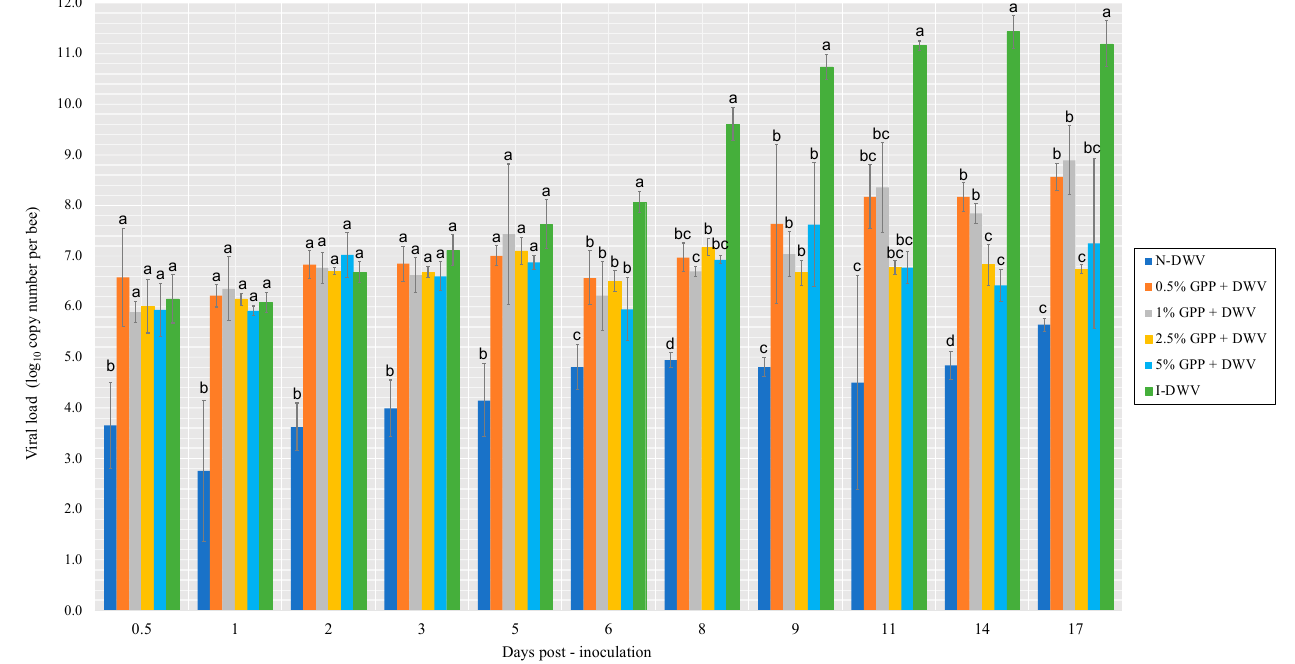
Figure 3. DWV loads in worker honeybees recorded in days post-inoculation throughout the assay. Grape pomace powder (GPP) concentrations (0.5, 1, 2.5 and 5%), and inoculated control (I-DWV) and non-inoculated control (N-DWV) are shown in different colors. Different letters indicate significant differences according to a Tukey’s test ( p <